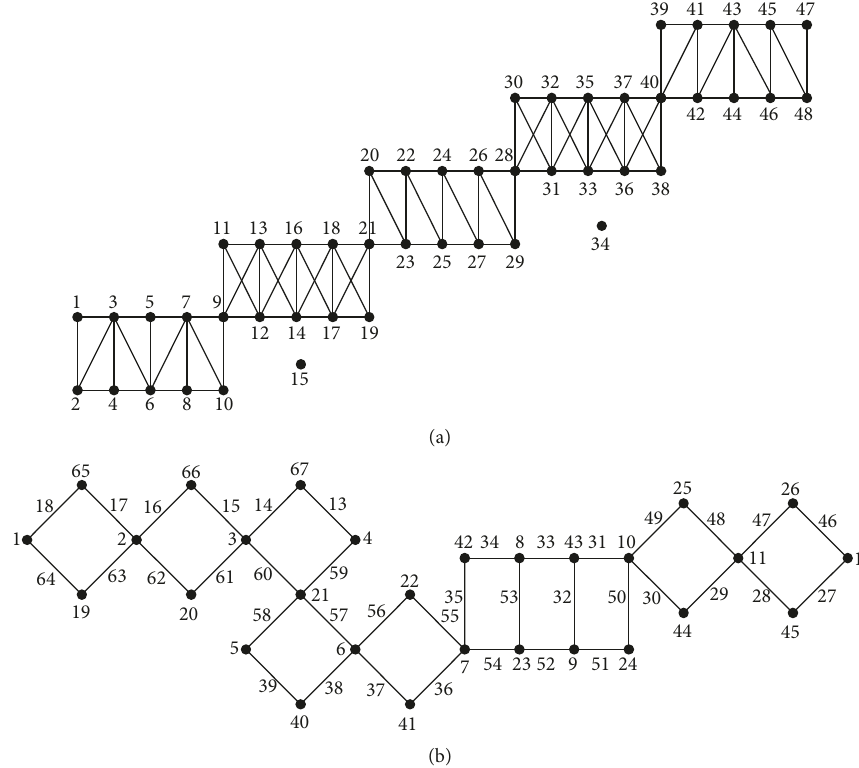
Figure 1: (a) Vertex labeling of 𝐶[ TL 5 , DL 5 , TL 5 , DL 5 , TL 5 ] ∪ 2𝐾 1 with string (4, 5, 4). (b) Vertex and edge labelings of 𝑐[𝐶 (3+2) 4 , 𝐿 4 , 𝐶 (2) 4 ] with string (2, 1 (2)